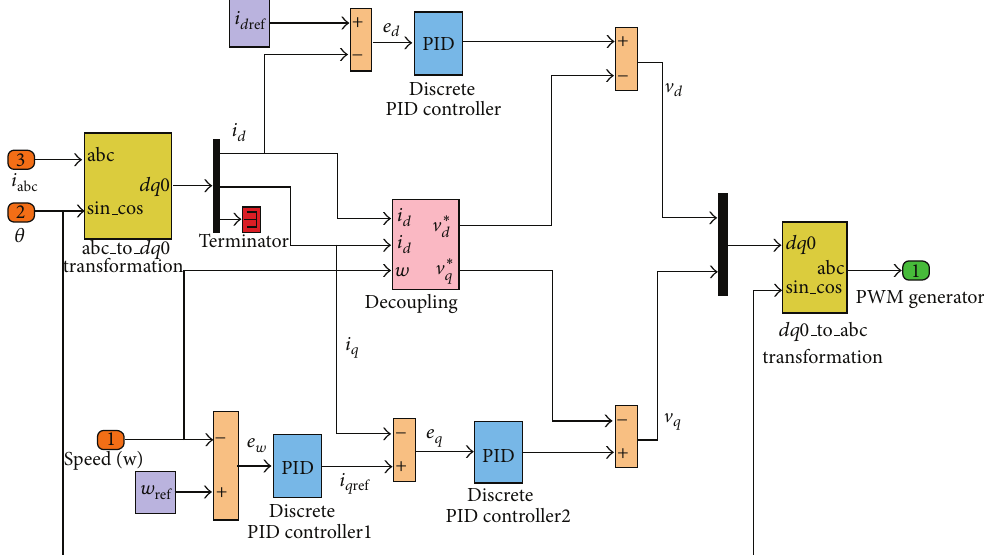
Figure 2: Detailed simulation block diagram of PMSG-side converter